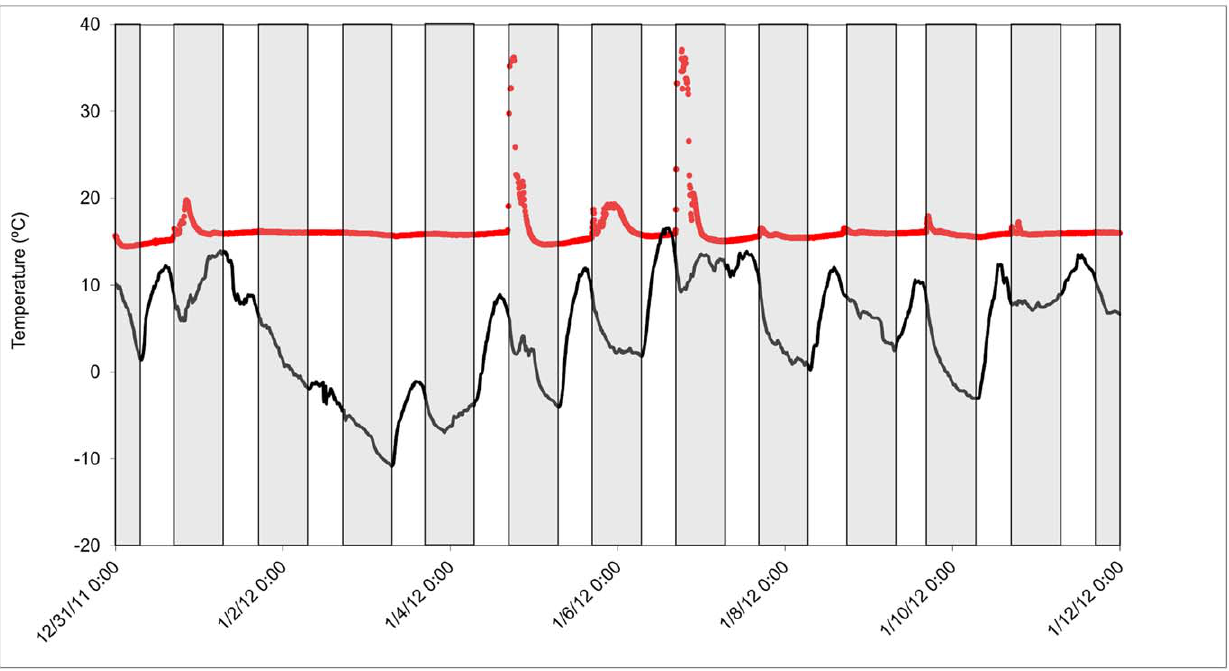
Figure 4. Skin temperatures (red circles) of a female Rafinesque’s big-eared collected through radio-telemetry and concurrent ambient temperatures outside the cave (black line) recorded over 12 days at Mammoth Cave National Park, Kentucky, USA. Shaded areas include hours between sunset and sunrise.